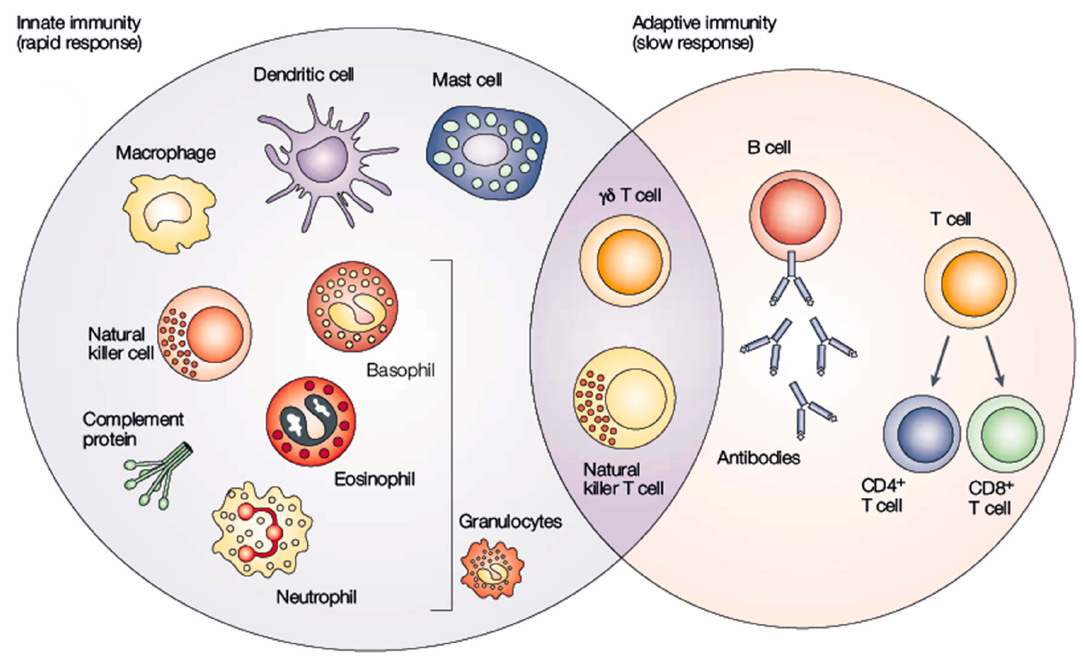
Figure 2. Interaction between innate and adaptive immune systems. Adapted from [25]. Cells from innate immunity are generated by myeloid lineage cells and mature into monocytes, macrophages, erythrocytes, platelets, and granulocytes, providing the first line of defense. Cells from the adaptive immune system come from lymphoid progenitor cells and provide natural killer (NK) cells, B-cells, and T-cells that are responsible for the second line of defense against pathogens and other abnormalities [26]. Magrophages and denditric cells (DC) from the innate immune system can recognize external antigens through pattern recognition receptors and trigger naive CD8+ and CD4+ T-cells, respectively, from the adaptive immune system [27]. The triggering of CD4 or CD8 depends on whether the epitope (part of antigen) is presented by MHC-I or MHC-II. MHC-I can be found in any human cells, and the recognition and presentation of epitope is re- stricted by MHC-I trigger CD8 T-cells. MHC-II molecules are only presented in neutrophils, macrophages, and DC (the so-called antigen-presenting cells) presented epitopes to CD4 T-cells [28]. Additionaly, professional antigen-presenting cells (APC) interact with T-cells using positive and negative feedback systems by producing cytokines. These cytokines, and other mediators such as hormones, and other antigens will stimulate the innate im- mune system to produce either IL-12 or IL-4 in the local microenvironment around a newly activated T cell. This so called native Th0 lymphocytes may be differentiated into T helper type 1 (Th1) cells when they are activated in a microenvironment rich in IL-12 or can be inhibited from developing into Th1 cells in case the microenvironment is rich in IL-4, IL-10, or other substances such as corticosteroids and catecholamines. In fact, the same naïve Th0 cells, if exposed to IL-4, will differentiate into T helper type 2 (Th2) cells. However, exposure of naive Th0 cells to IL-12 inhibits polarization to Th2 cells. It is important to understand that when both IL-4 and IL-12 are present upon activation of naive T-cell, the effects of the IL-4 will dominate, and a type 2 response will